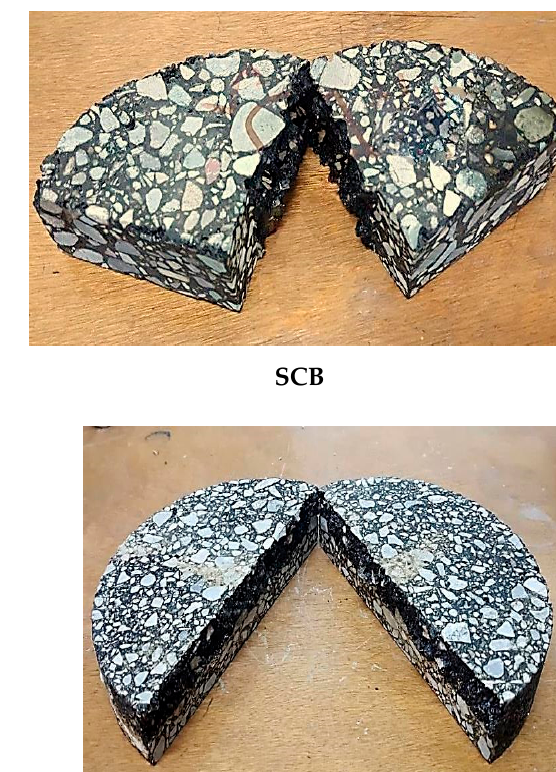
Figure 6. Test setup (before and after failure) for conducting the fracture experiments using different test configurations.